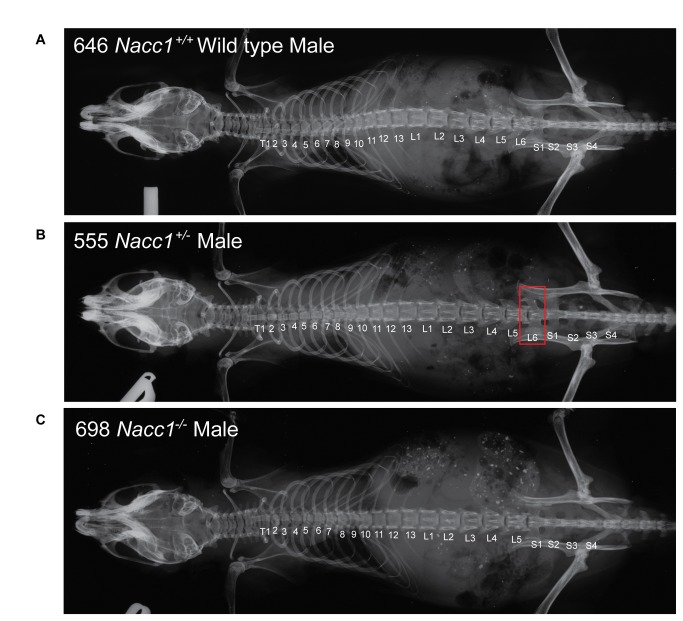
Reduced NAC1 expression alters axial skeletal patterning.The images show representative whole-body radiographs comparing the skeletal organization of adult Nacc1+/+ (wild type, A), Nacc1+/- (heterozygous, B), and Nacc1-/- (knockout, C) mice. The major defects are an absence of the sixth lumbar vertebra (L6) in the Nacc1-/- mouse and an intermediate phenotype showing partial transformation of L6 into a sacral identity (B, red box). The numbers denote the number of vertebrae in the thoracic (T), lumbar (L), and sacral (S) regions of the vertebral column.